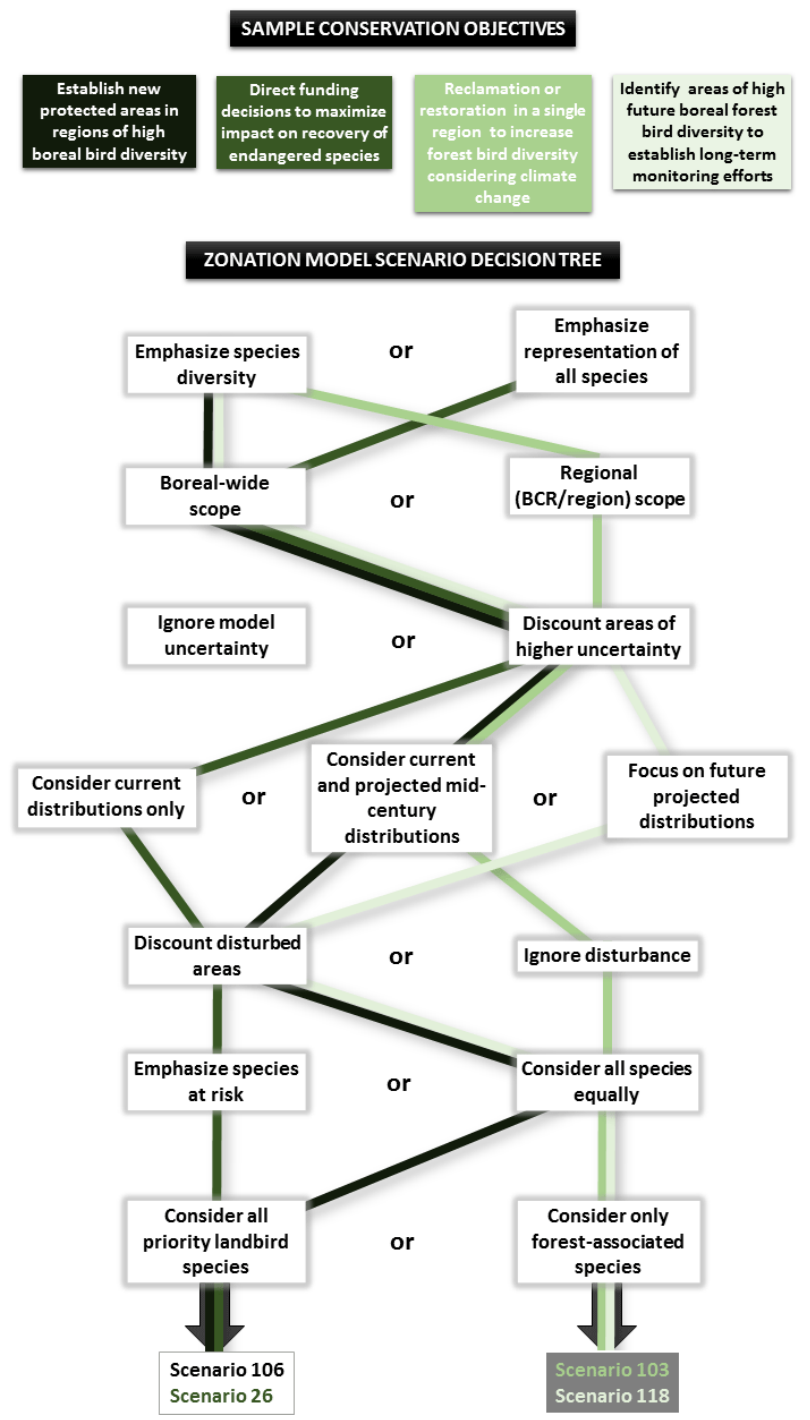
Fig. 1 . Scenario roadmap with example hypothetical conservation objectives. For example, if the objective is to identify new potential protected areas with high boreal bird diversity (black), one might select a boreal-wide scenario that emphasizes species diversity, discounts areas of higher uncertainty, includes both current and projected midcentury distributions, weights all species equally, and considers all priority songbird species, leading one to select scenario 106 (see Table A1.1 for definitions). Conversely, if the objective was regional habitat reclamation or restoration (medium green), one might select a geographically stratified scenario that does not discount for disturbance, e.g., scenario 103. Theoretically, each of the 128 scenarios we generated could be the desired scenario for a different conservation objective. BCR = bird conservation